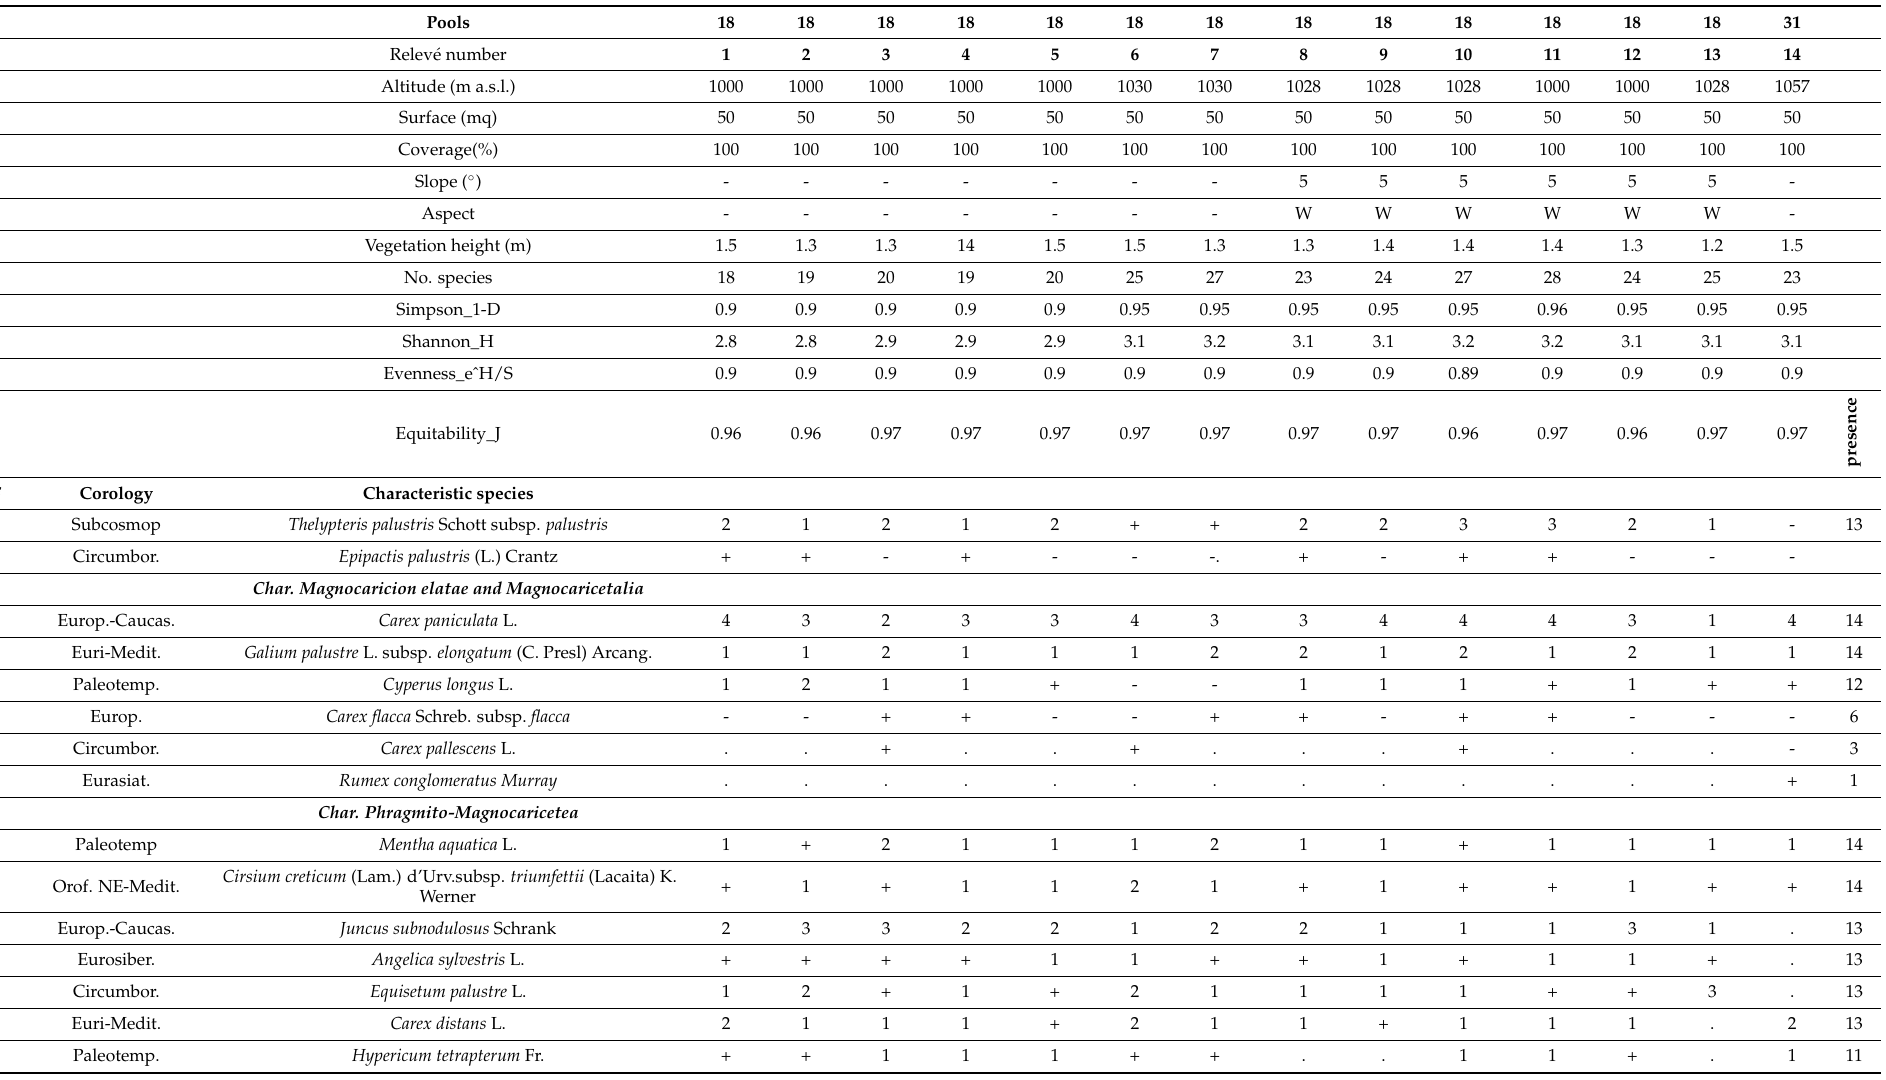
Table 1. Thelypterido palustris-Caricetum paniculatae ass. nova hoc loco–Sampling plots main features of plant community investigated